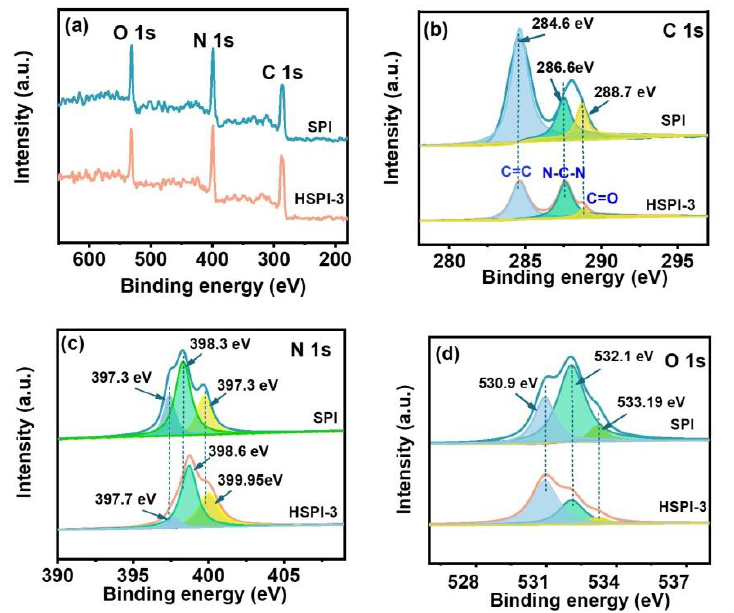
Figure 5. ( a ) XPS survey spectra for BSPI and HSPI samples; XPS spectra of ( b ) C 1s, ( c ) N 1s, and ( d ) O 1s of BSPI and HSPI-3 samples.